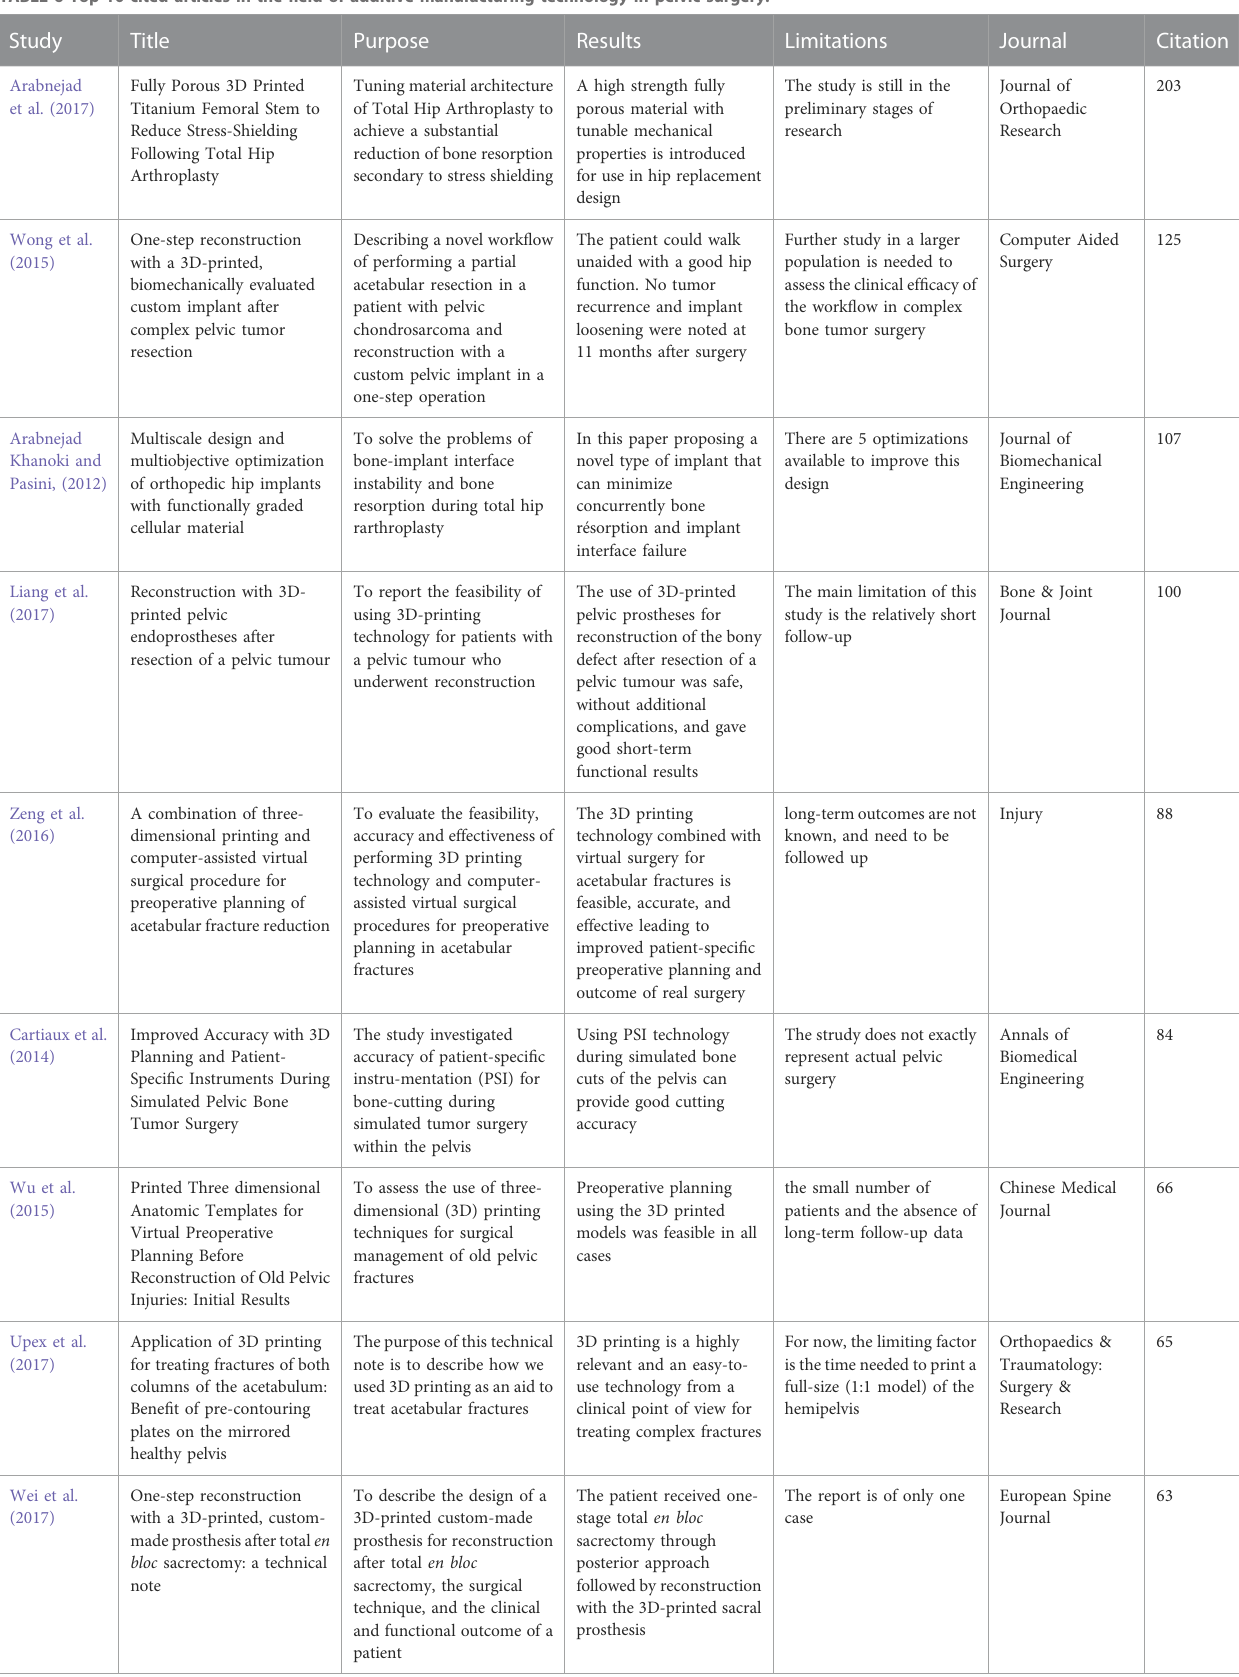
TABLE 6 Top 10 cited articles in the fi eld of additive manufacturing technology in pelvic